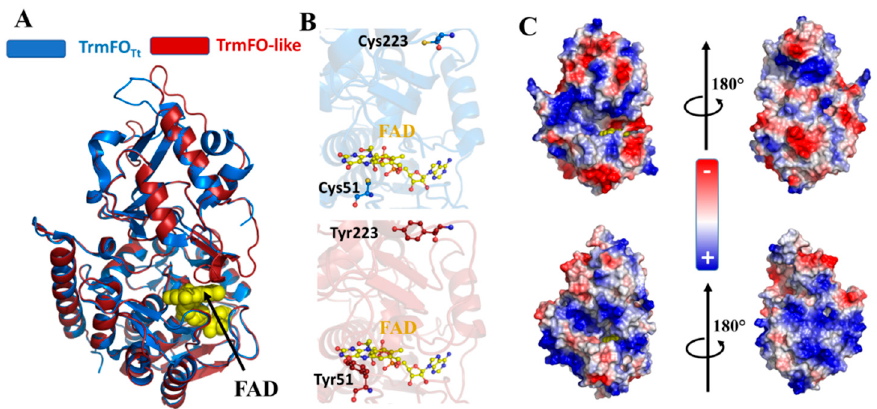
Figure 6. Structural model of TrmFO-like protein. ( A ) Structural overlay of the crystal structure of T. thermophilus TrmFO (blue) with the 3D model of M. capricolum subsp. capricolum TrmFO-like protein MCAP_0613 (red). The FAD coenzyme is represented as ball sticks in yellow. ( B ) Location of the two cysteines (top panel) that are strictly conserved and required for m 5 U54-tRNA methylation activity in TrmFO Tt . The lower panel shows the two tyrosine residues at the corresponding locations in TrmFO-like proteins. ( C ) Electrostatic surface of TrmFO Tt (top) and the TrmFO-like protein MCAP_0613 from M. capricolum